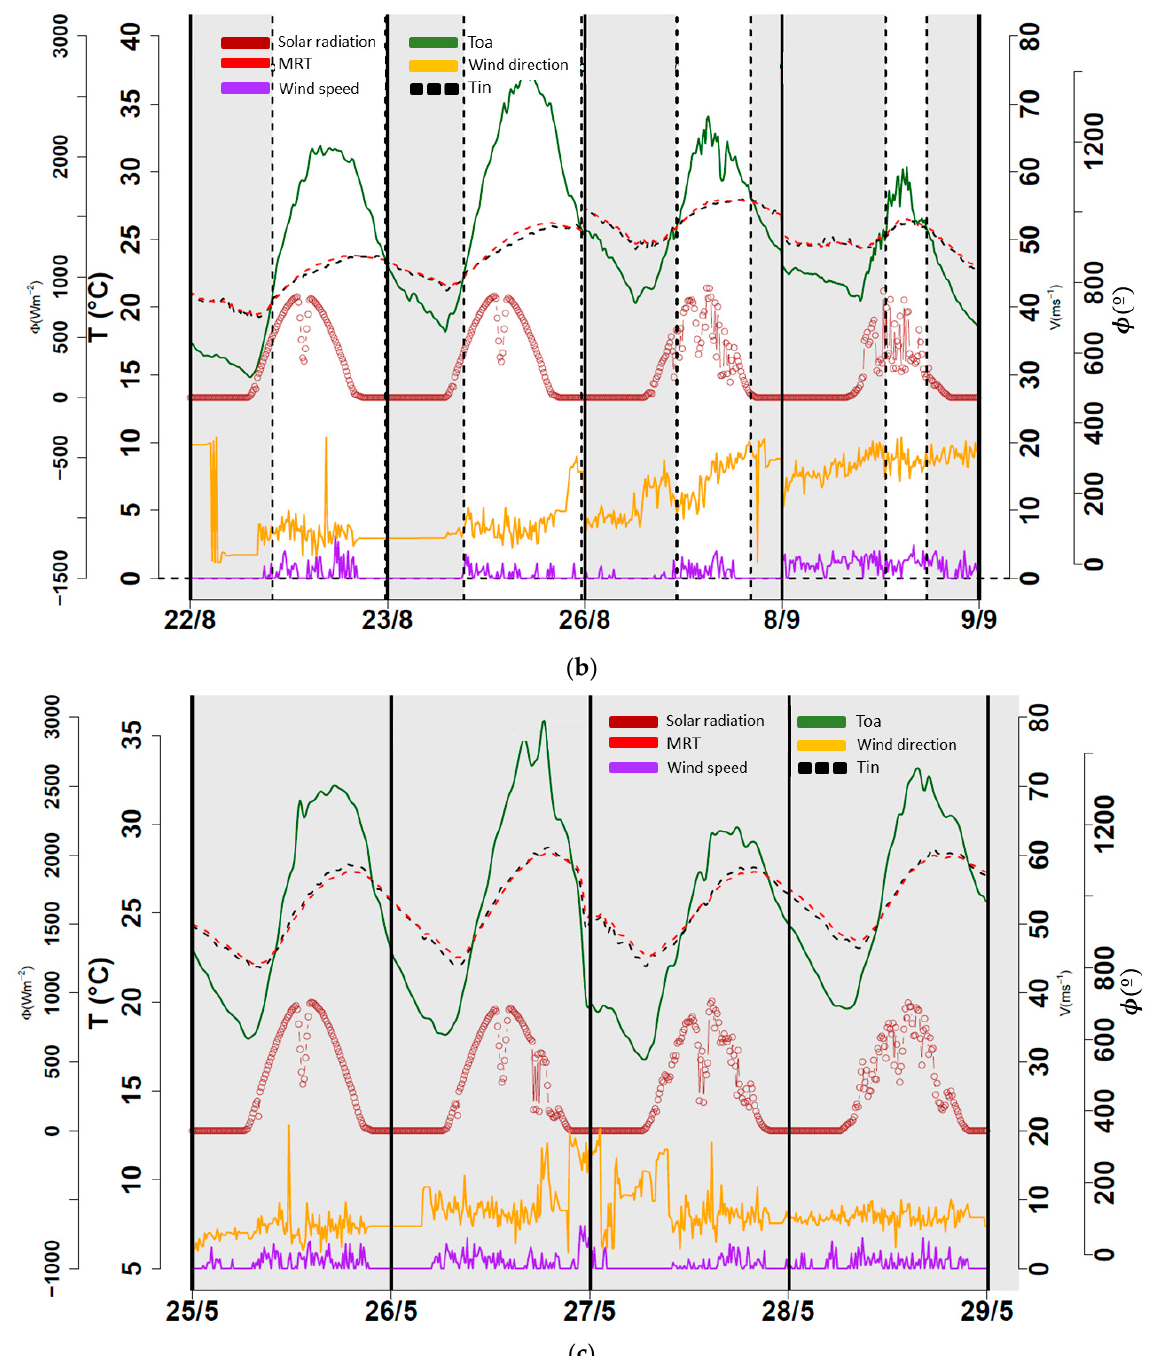
Figure 5. Weather data, along with the indoor air and mean radiant temperatures. ( a ) Configuration #1. ( b ) Configuration #2, moments where openings remained opened (gray zones). ( c ) Configuration #3, moments where openings remained opened (gray zones).